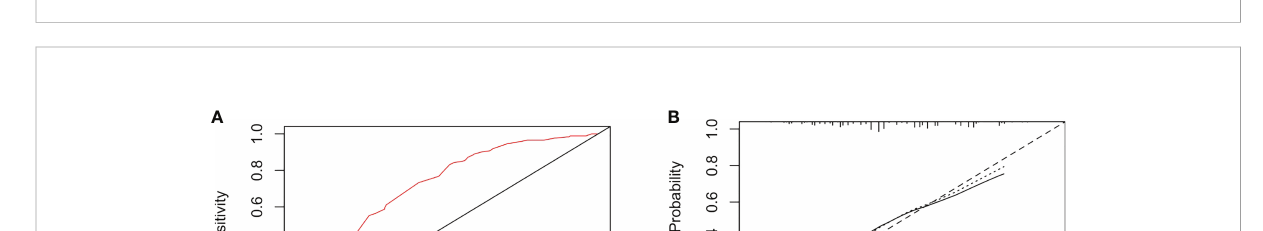
FIGURE 1 Papillary thyroid cancer nomogram for predicting lymph node metastasis.